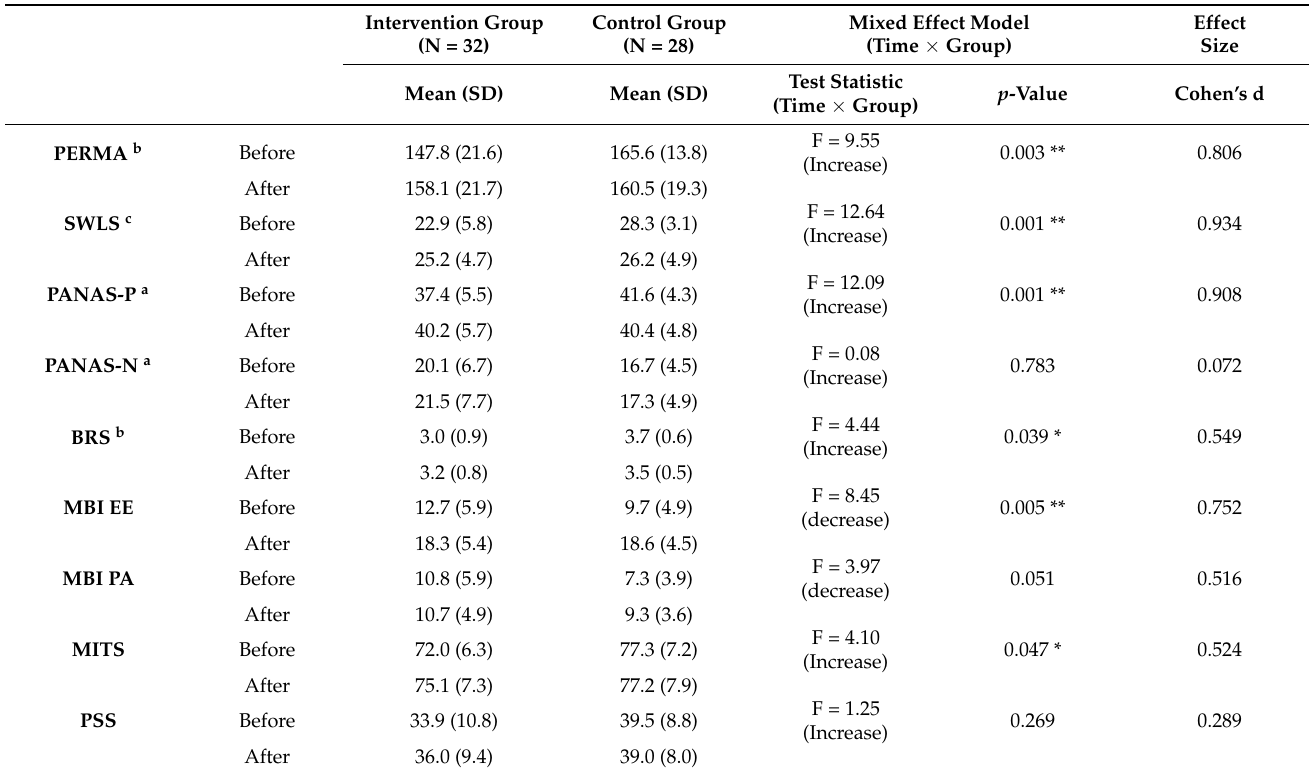
Table 2. Effects of IBSR intervention between the study